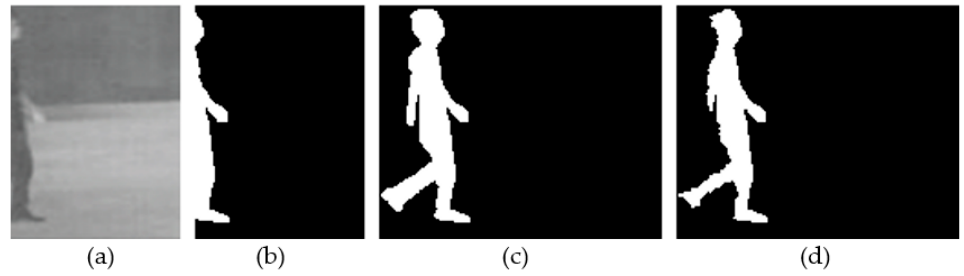
Figure 21. Example images by human segmentation from fold-2: ( a ) original images; segmentation results using ( b ) original images and ( c ) GT images; and the images predicted by ( d ) the proposed method.